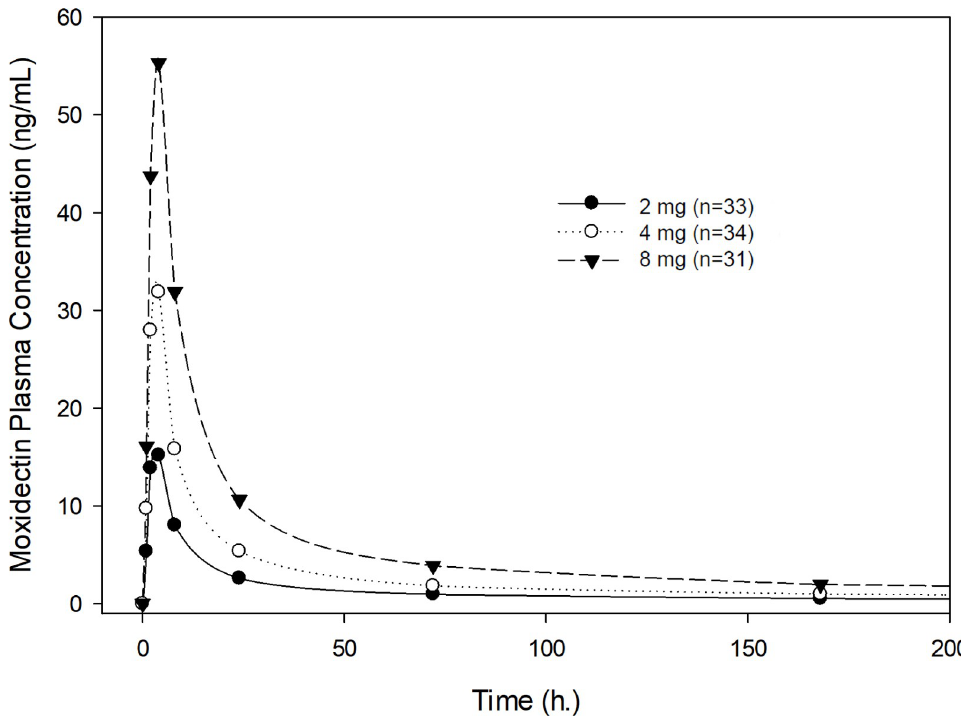
Fig 1. Plasma concentrations of moxidectin after single oral administration of 2, 4 or 8 mg, displayed as geometric means.